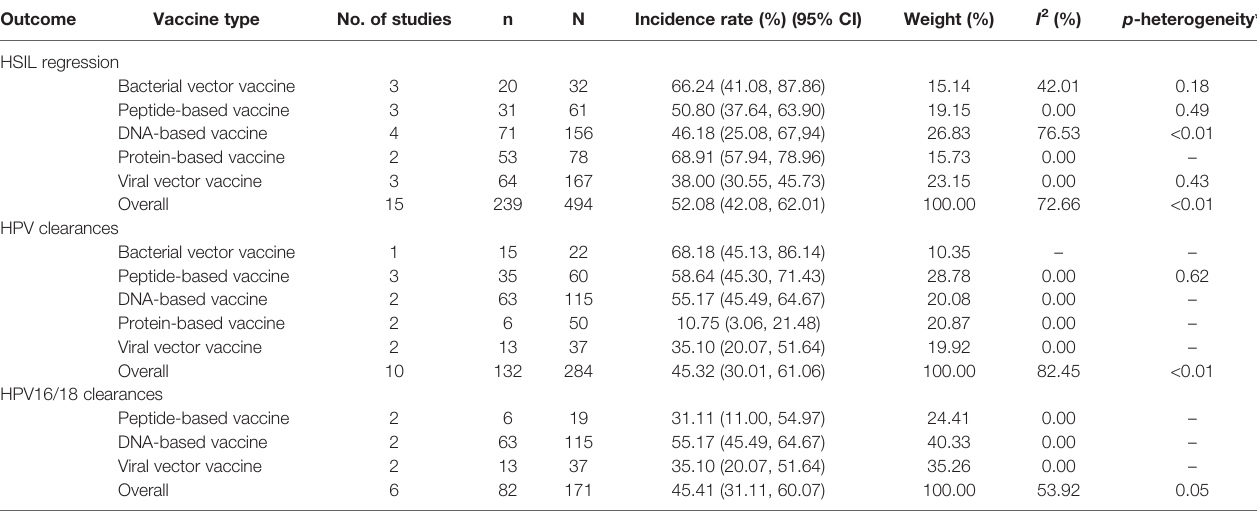
TABLE 3 | Adjusted effectiveness of therapeutic vaccines for precancerous cervical lesions. Outcome Vaccine